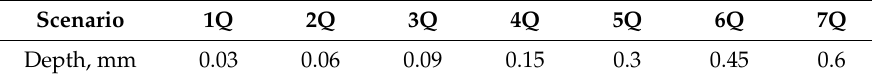
Table 2. The damage scenarios for the damage quantification.